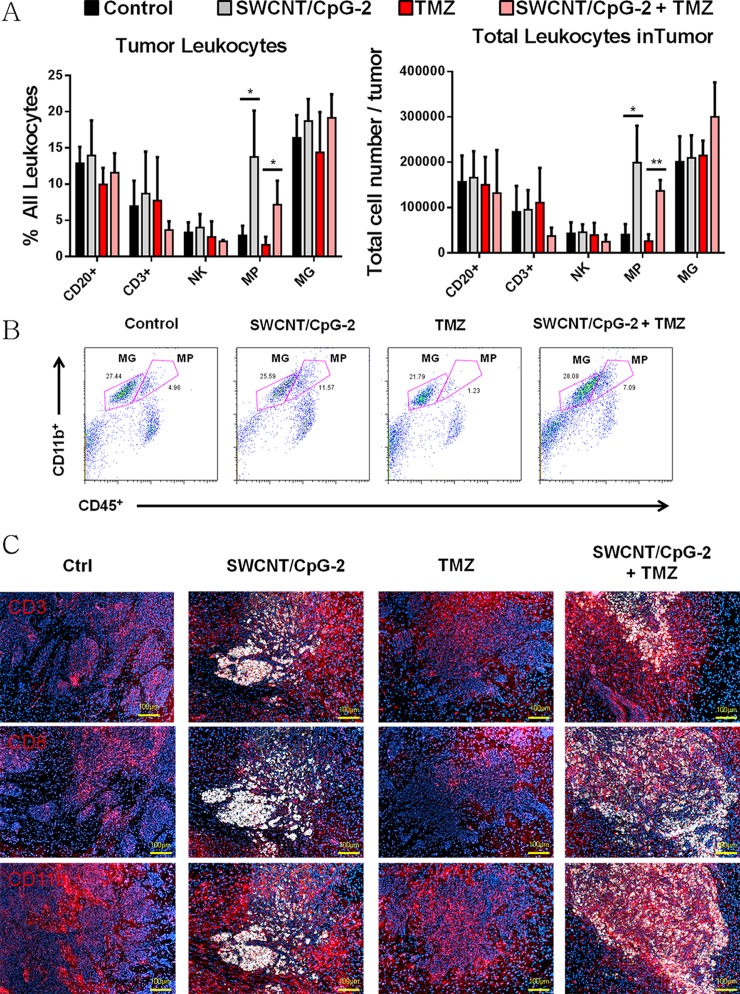
SWCNT/CpG-2 + TMZ treatment increases the proportion of macrophages in the tumor.(A) Proportion (left panel) and absolute number (right panel) of tumor infiltrating CD20+, CD3+, NK, MP (CD11b+CD45high) and MG (CD11b+CD45low) cells (unpaired two-tailed t-test * P < 0.05 and ** P < 0.01, n = 3). (B) Representative flow cytometry data of percent MP (CD11b+CD45high) and MG (CD11b+CD45low) cells in tumor after treatments. (C) Representative fluorescent imaging of tumor infiltrating CD3+, CD8+, and CD11b+ cells 10 days after treatment (14 days after tumor implantation). Scale bar is 100 μm.